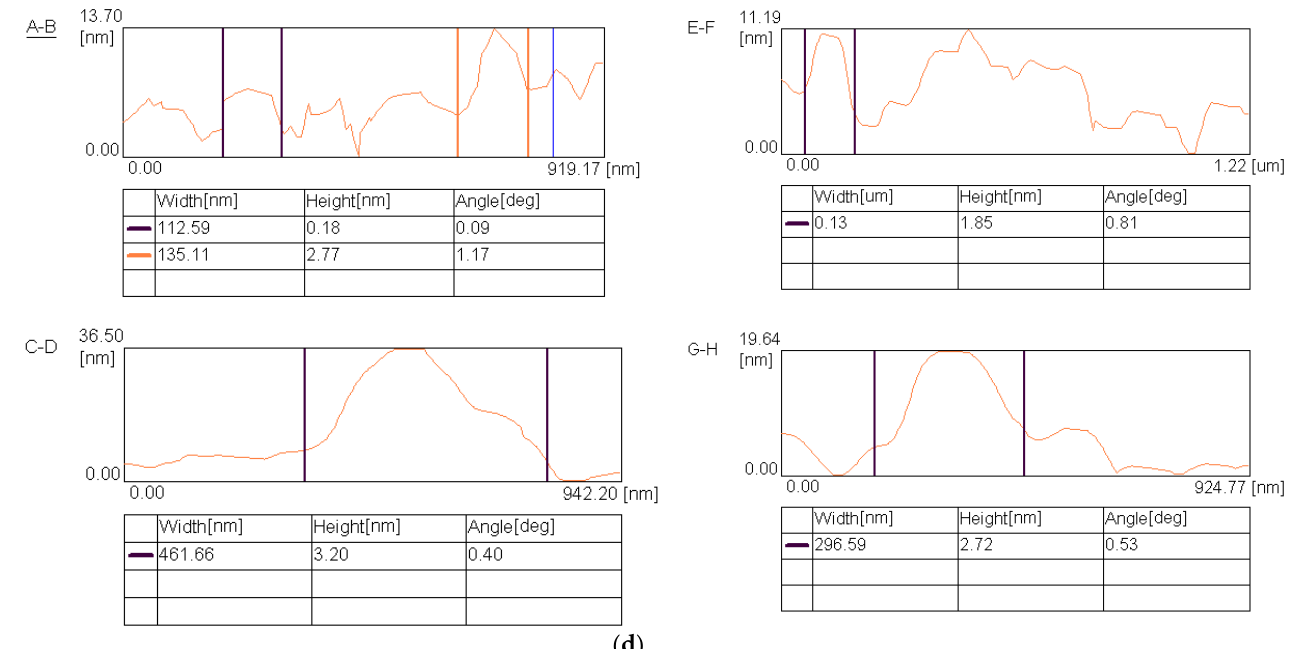
Figure 7. ( a ) 2D and ( b ) 3D AFM images of TPPNi thin film in contact mode, ( c ) 2D deflection mode AFM image and ( d ) cross - sectional surface profile of pristine TPPNi thin film.